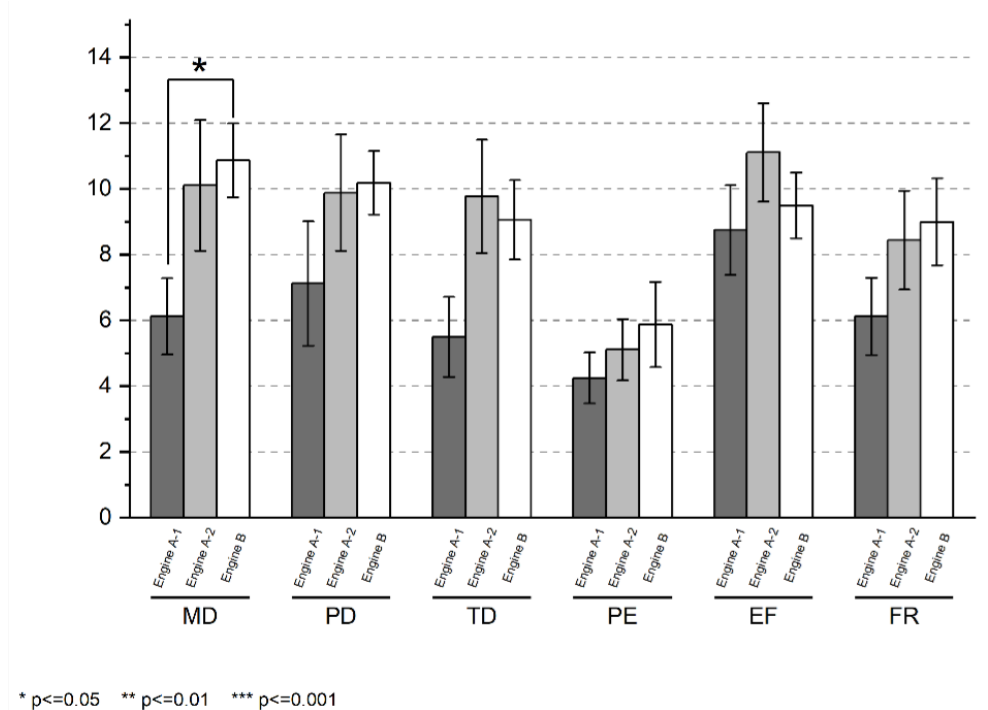
Figure 39. Subscale of NASA-TLX workload in engine maintenance task. Hypothesis 7. Figure 40 depicts the NASA-TLX overall mean values and standard errors regarding the PC assembly task. The results of ANOVA revealed no significant differences between PC A (M = 40.75 and SD = 21.25) and PC B (M = 45.59 and SD = 20.01), F = 0.454 and p = 0.506. Figure 41 exhibits the scores for each NASA-TLX subscale. The results of the Mann–Whitney U test revealed that the system equipped with tracking had no significant impact on the MD ( U = 120.50, p = 0.575), PD ( U = 128.00, p = 0.773), PE ( U = 119.50, p = 0.548), EF ( U = 107.50, p = 0.303), and FR ( U = 120.50, p =